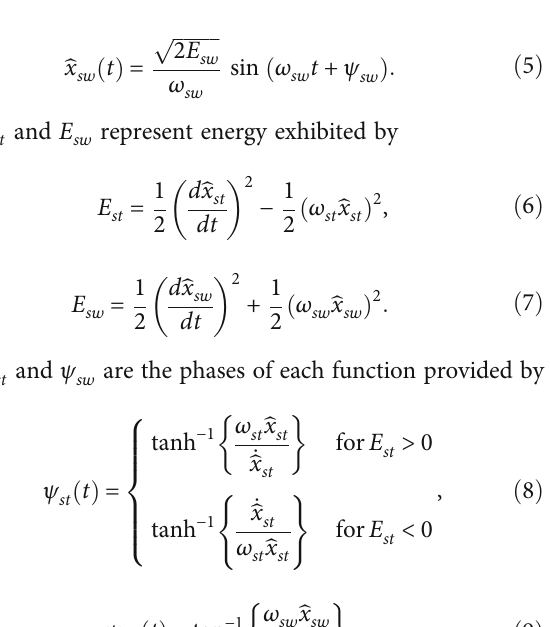
Figure 1: Measurement of human gait and analysis of gait kinematics for calculation of the COM of the body segments. (a) Measurement of the positions of the heel, ankle, knee, hip, and shoulder joints of the left and right sides by a motion capture system (OPTOTRAK). (b) The COM of the feet, shanks, thighs, and head-arms-trunk segments were estimated by a 7-link kinematics model.